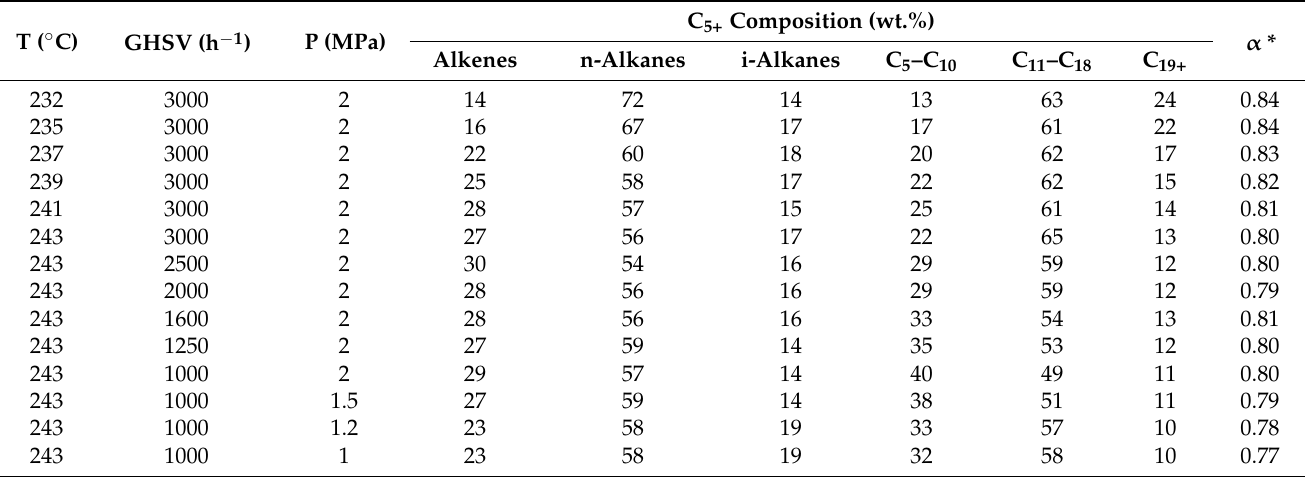
Table 6. Composition of C 5+ hydrocarbons synthesized under different FTS